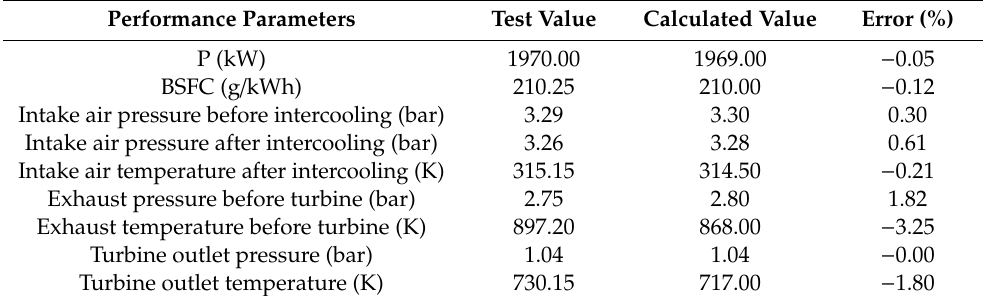
Table 3. Comparison of calculation and routine test on the performance and thermal parameters.